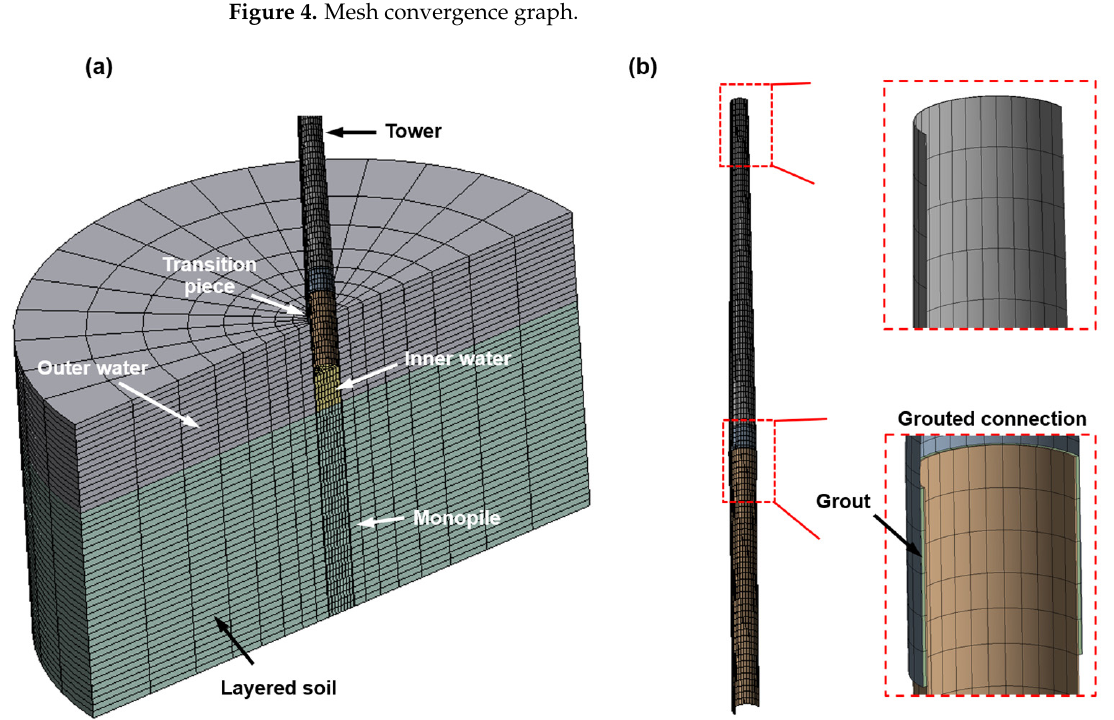
Figure 5. FE model for ( a ) structures with soil layers and ( b ) tubular steels.